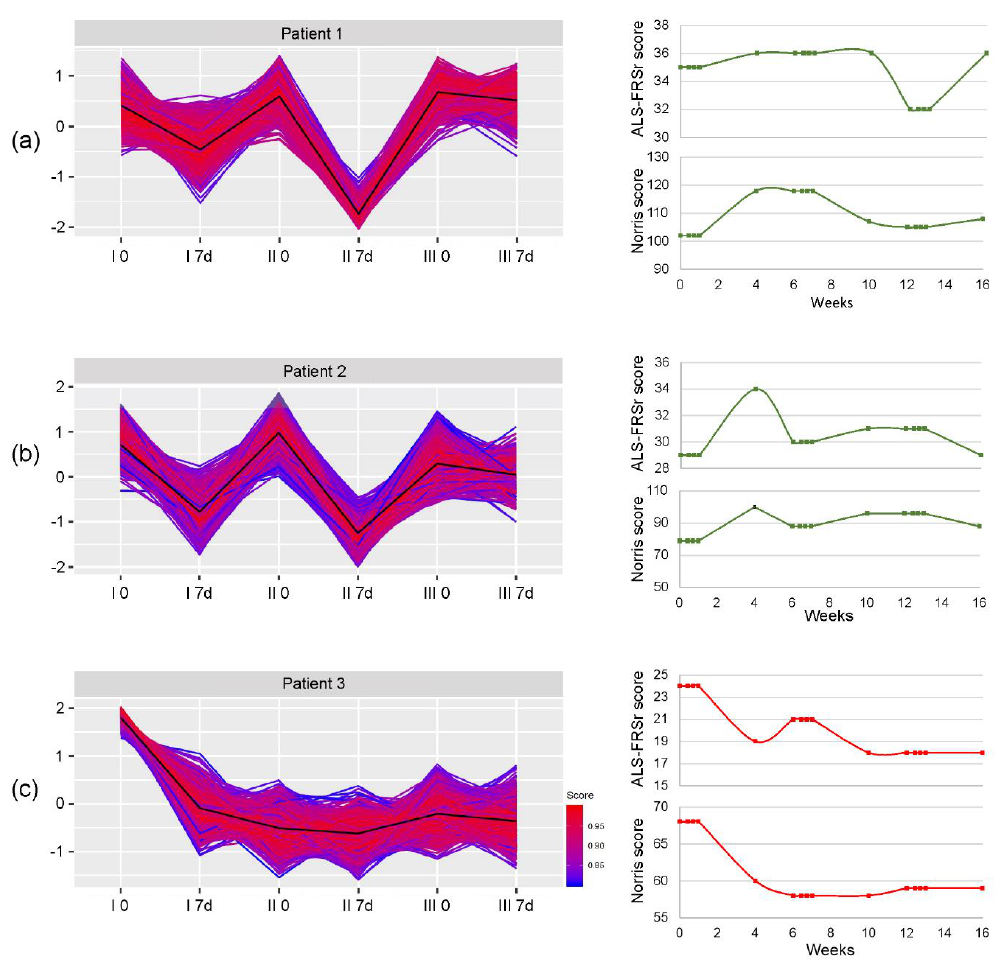
Figure 4. Changes in the expression of genes assigned to biological processes related to neutrophil activation, degranulation, and neutrophil-mediated immunity in three patients: ( a ) Patient 1, assigned to the responders group; ( b ) Patient 2, also assigned to the responders group; ( c ) Patient 3, who has been assigned to the non-responders group. Additionally, the results of functional assessment with the ALS-FRSr and Norris scale have been presented for each patient separately. Green curve—patients qualifying for the responders group; red curve—patients representing the non-responders